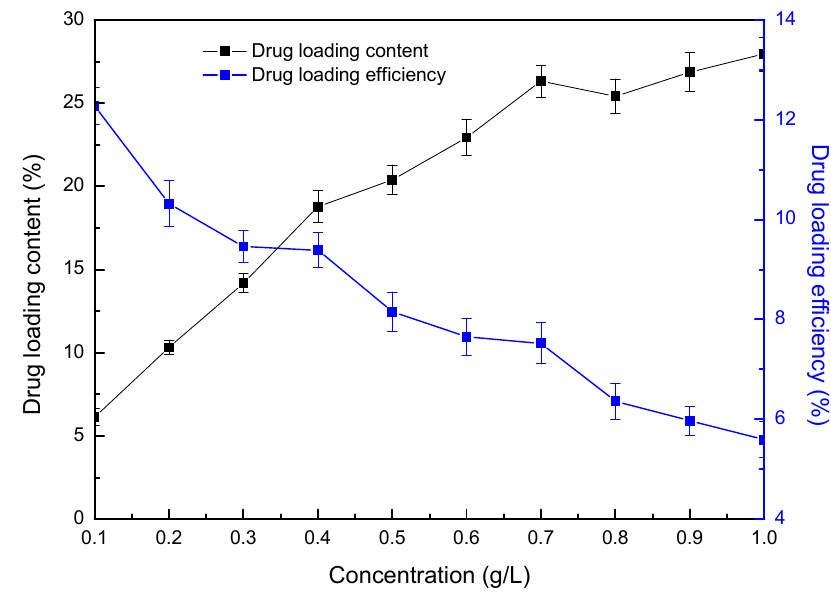
Figure 4. Effect of drug concentration on the loading content and loading efficiency.